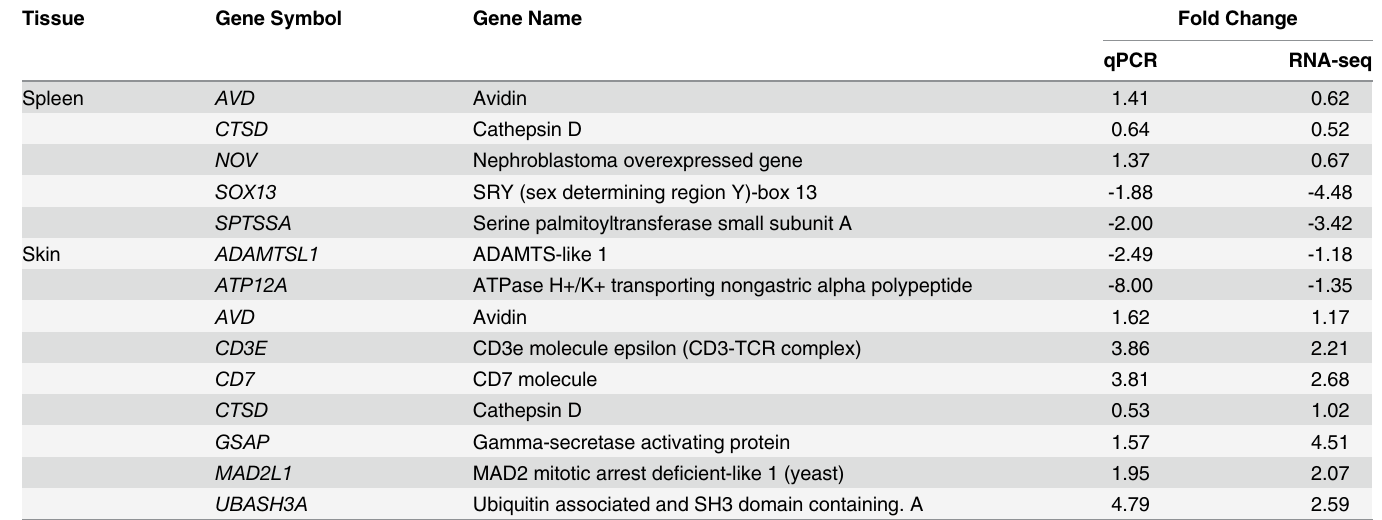
Table 4. Comparison between RNA-seq data and qRT-PCR results. Tissue Gene